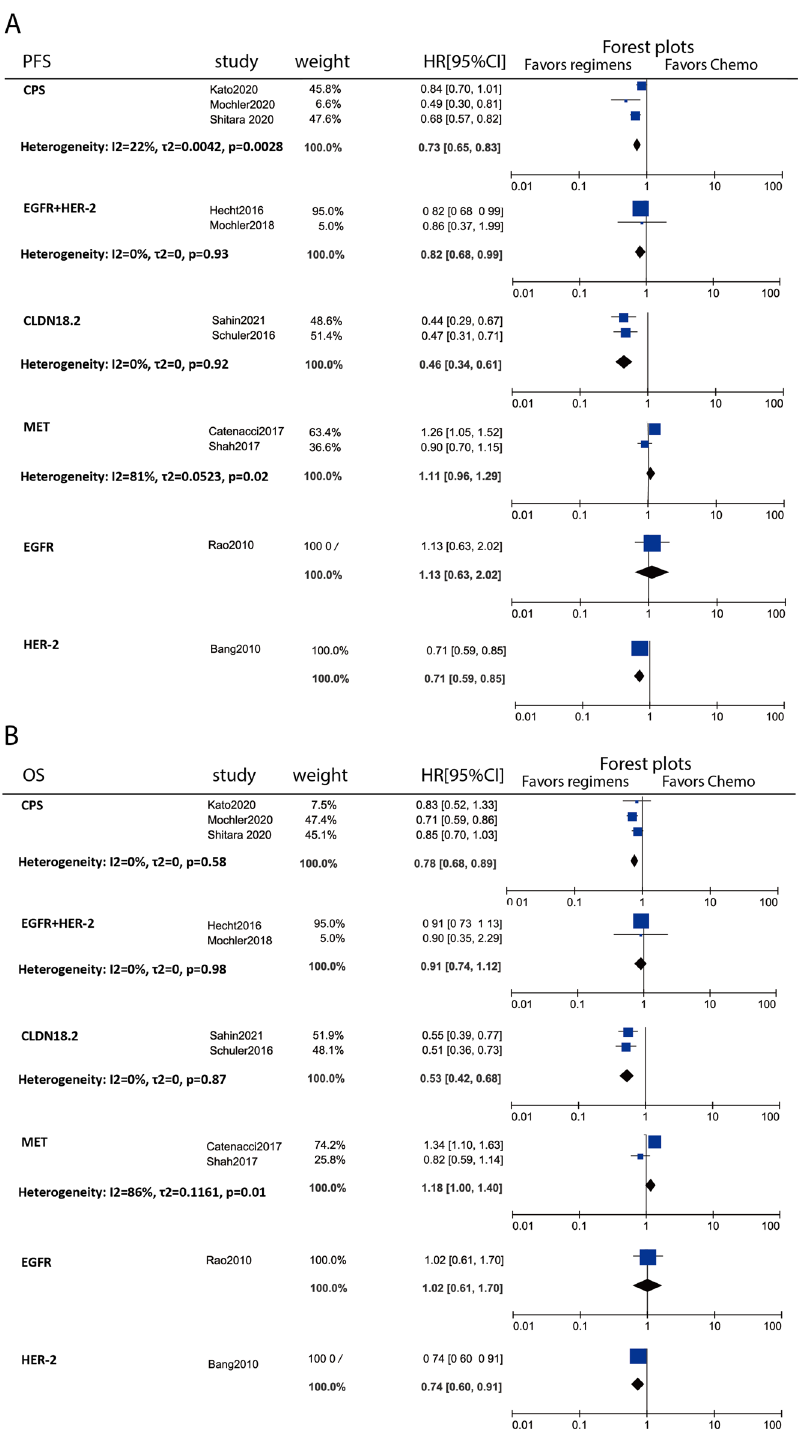
Figure 7. Pairwise meta-analysis forest plots for specific positivity group. ( A ) Forest plots of PFS; ( B ) Forest plots of OS. All regimens are compared with